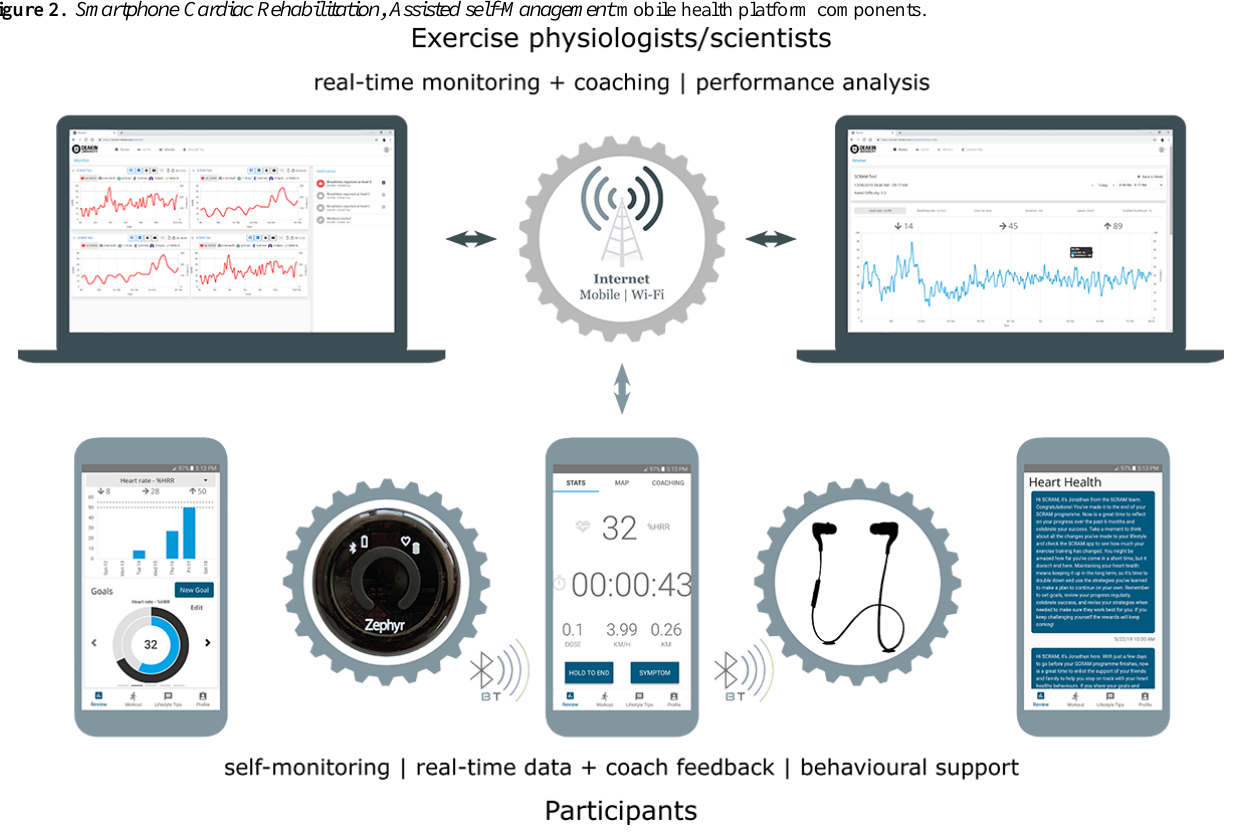
Figure 2. Smartphone Cardiac Rehabilitation, Assisted self-Management mobile health platform